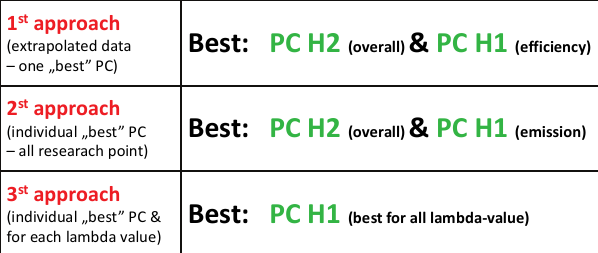
Table 6. Approach-dependent matrix of best PC